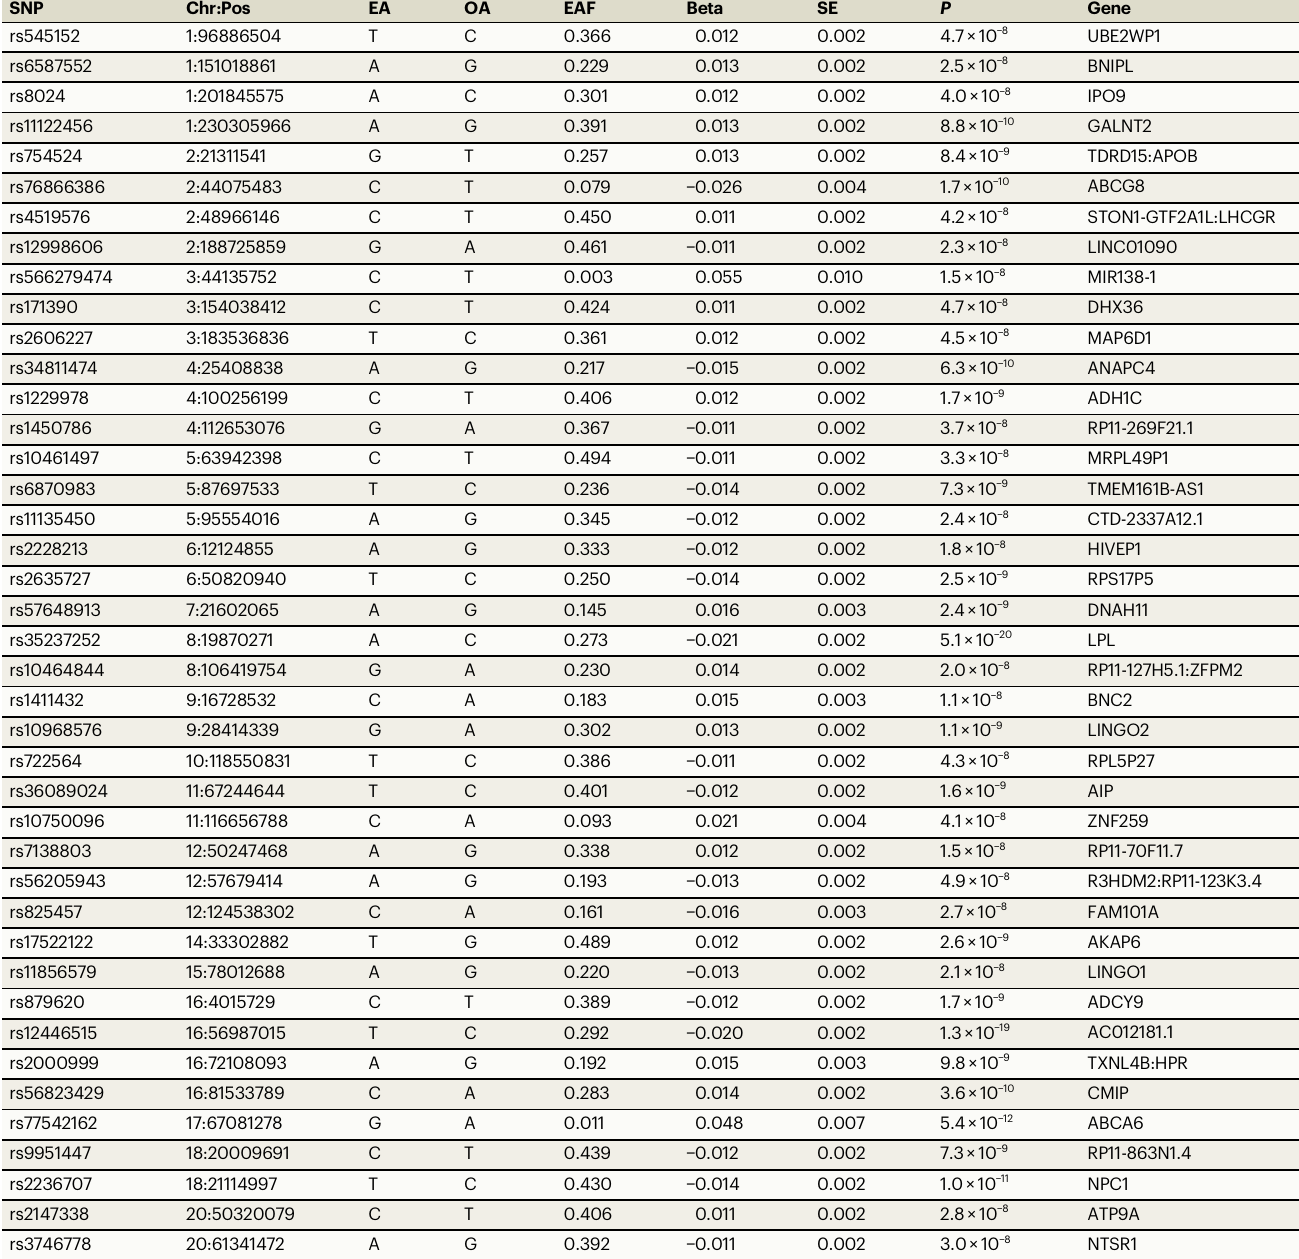
Table 1 | Novel genomic loci associated with C-reactive protein in genome-wide signi fi cance level (two-sided P < 5 × 10 − 8